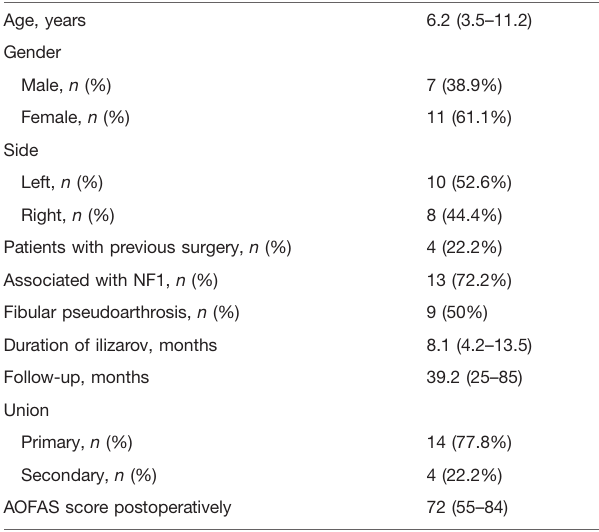
TABLE 1 | Demographic data and clinical